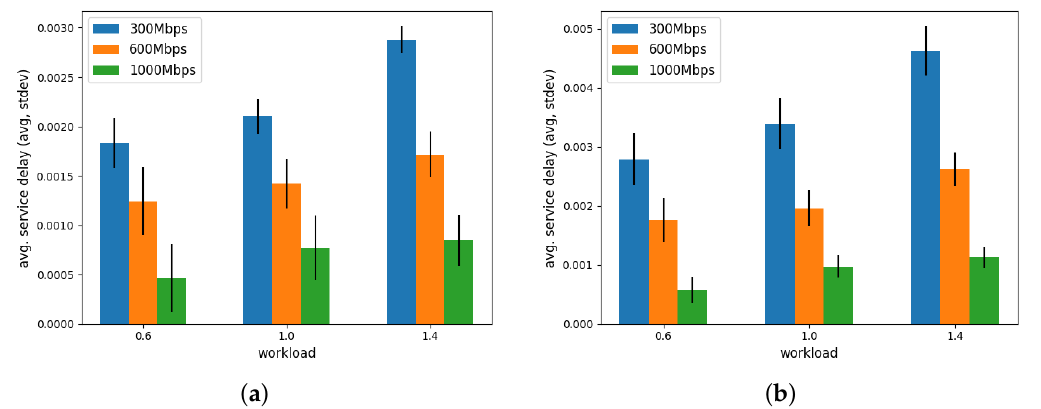
Figure 7. Impact of network bandwidth on the task service delay. ( a ) 10 MECSs; ( b ) 20 MECSs.